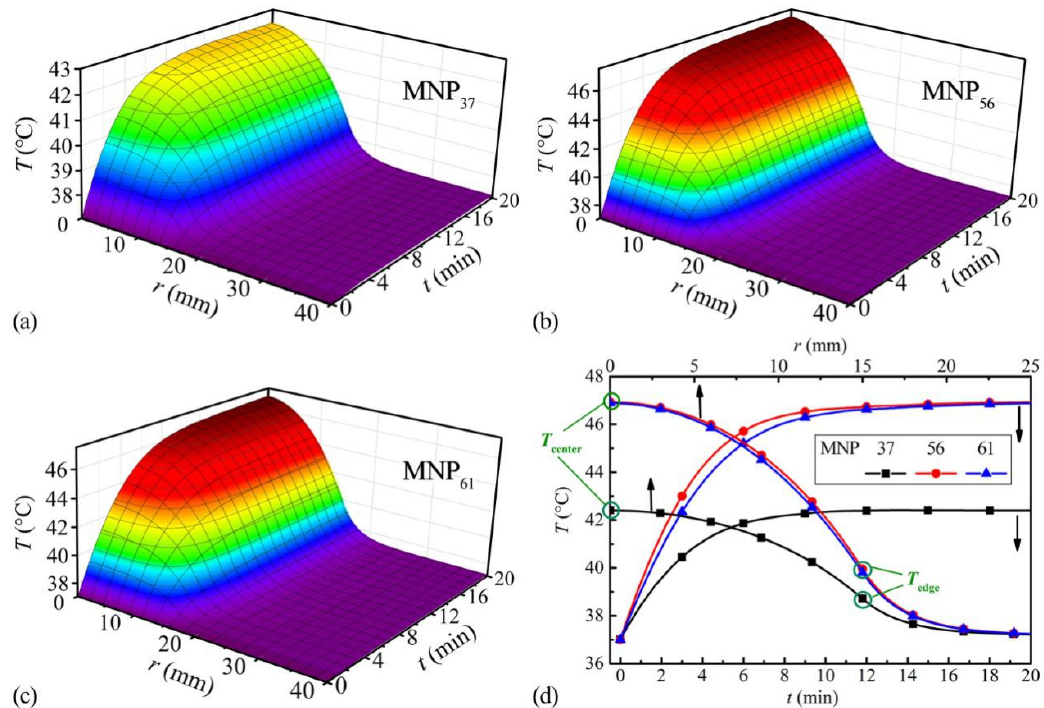
Figure 3. The time and spatial temperature changes in the tissue model of MNP 37 ( a ), MNP 56 ( b ) and MNP 61 ( c ), at 35 mg/mL MNP concentration; ( d ) The corresponding temperature rises of tumor centers (lower abscissa) and the final temperature distributions (upper abscissa).